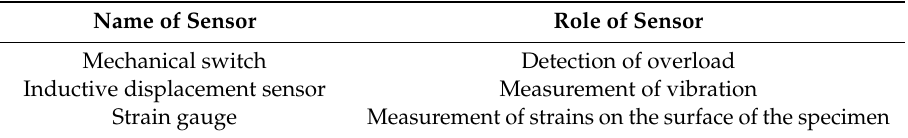
Table 1. List of sensors acquired for the developed testing